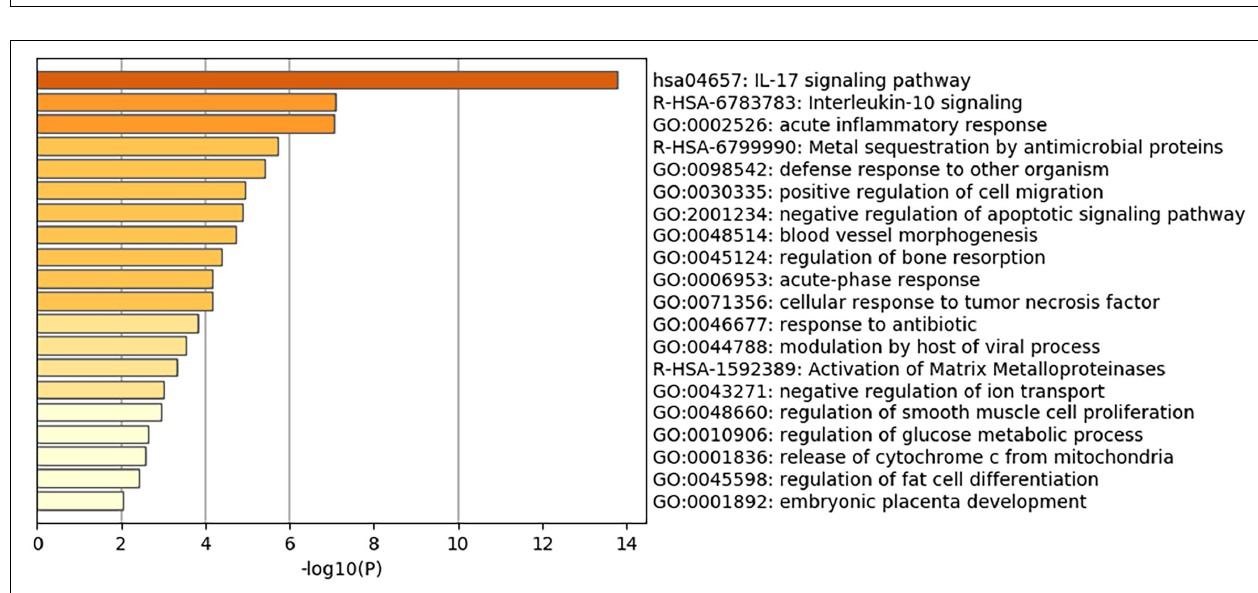
FIGURE 2 | Heatmap of top Gene Ontology (GO) of the top DEGs in infected normal epithelium versus mock-infected cells. The bars represent the –log10 of the adjusted p -value for each pathway.